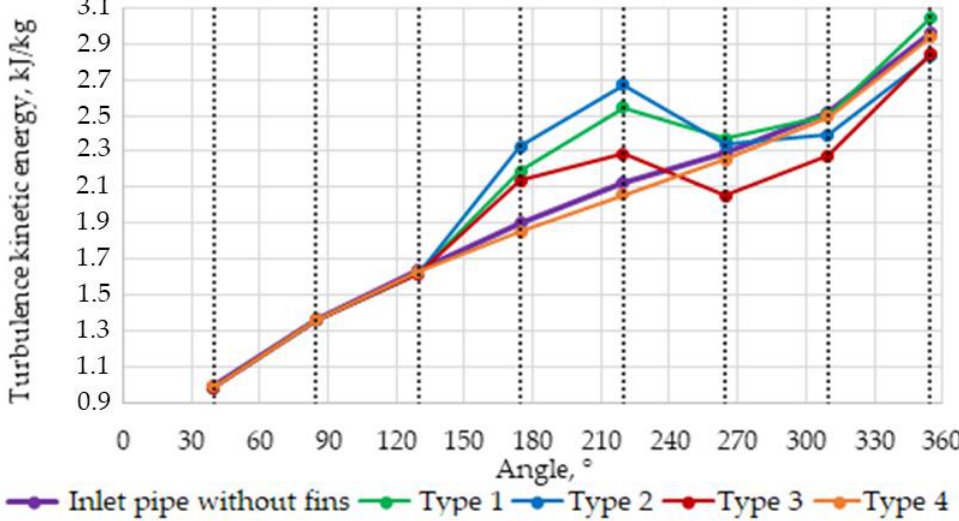
Figure 11. Distribution of the turbulence kinetic energy in inlet pipes with various fin types.